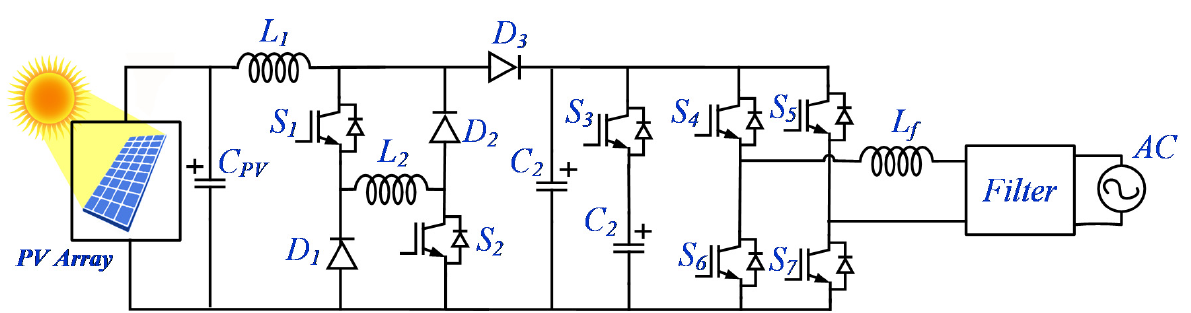
Figure 8. Period sharing boost converter with full-bridge transformerless inverter.